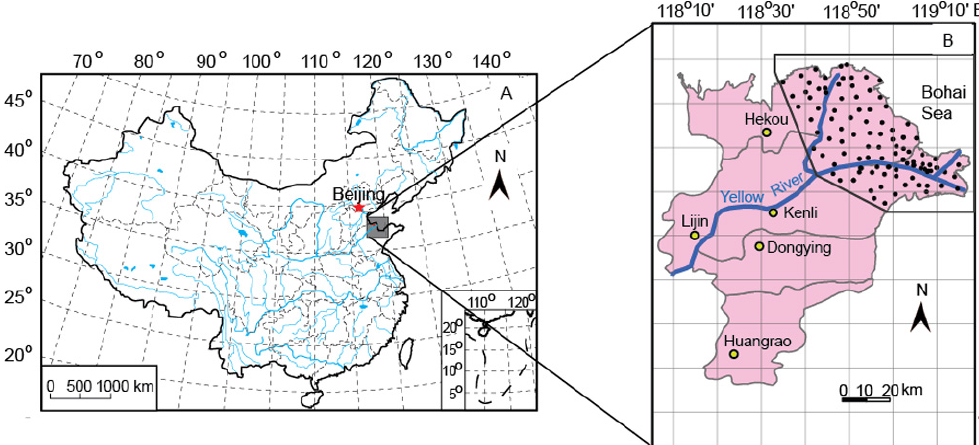
Fig. 1. Location of the modern Yellow River Delta (A) , the study region and sample sites (B) .